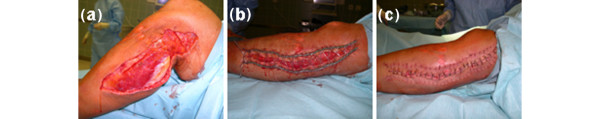
Wound management from primary surgery to delayed secondary closure. (a) Large-scale tissue damage at right lower extremity. (b) Cross-over technique for wound edge adaptation. (c) Definitive wound closure via suture.